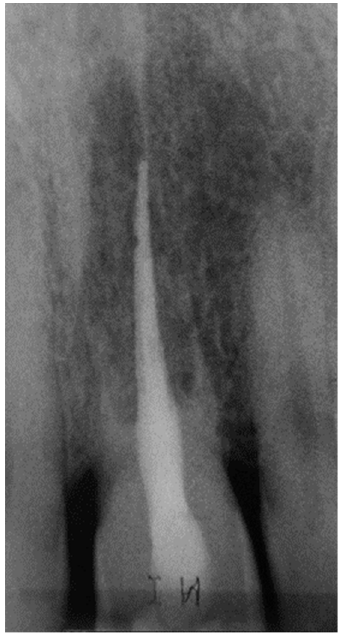
Figure 7. Rx at the 4-year recall visit.